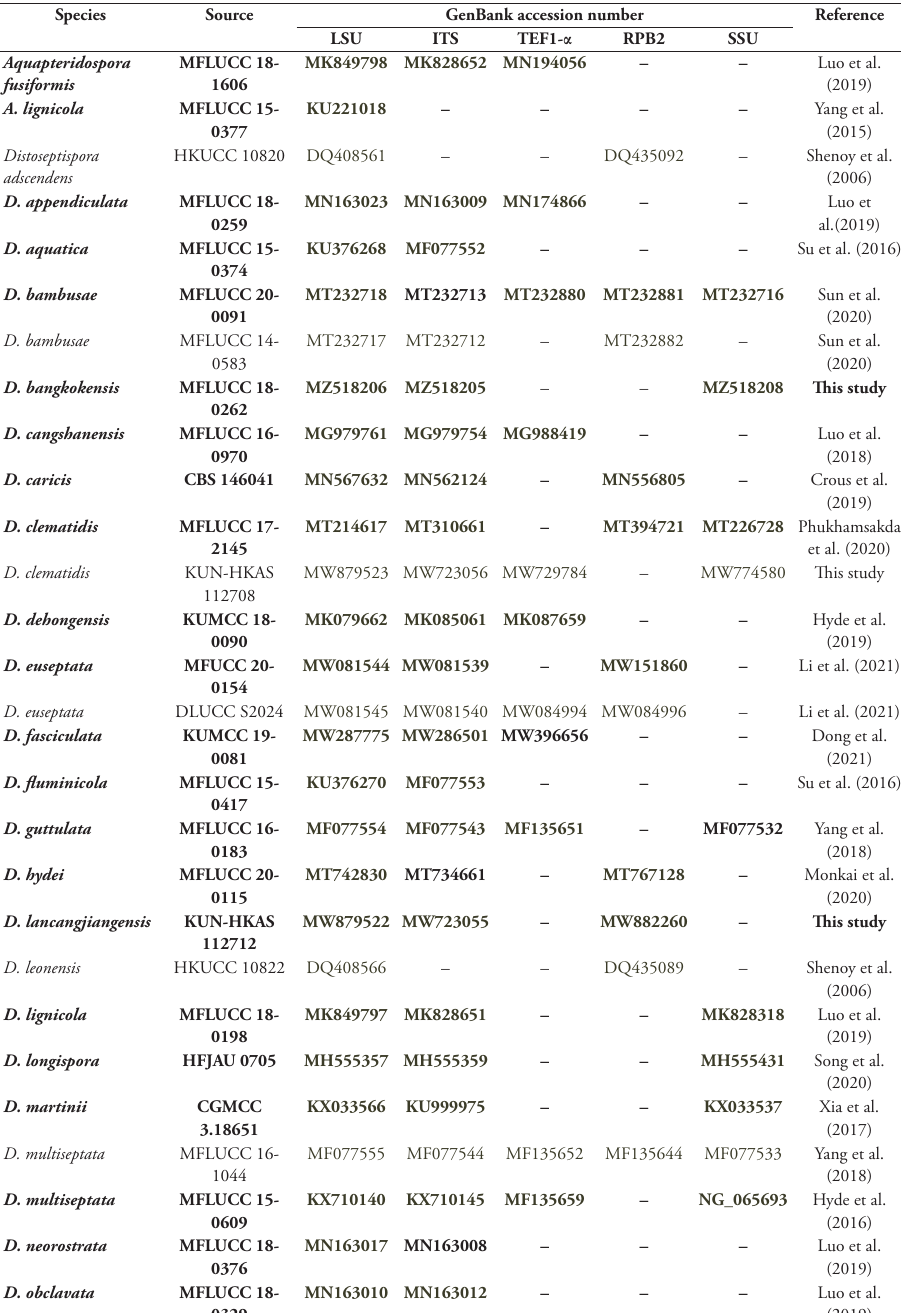
Table 1. Strains used for phylogenetic analysis and their corresponding GenBank numbers. The type strain are in bold